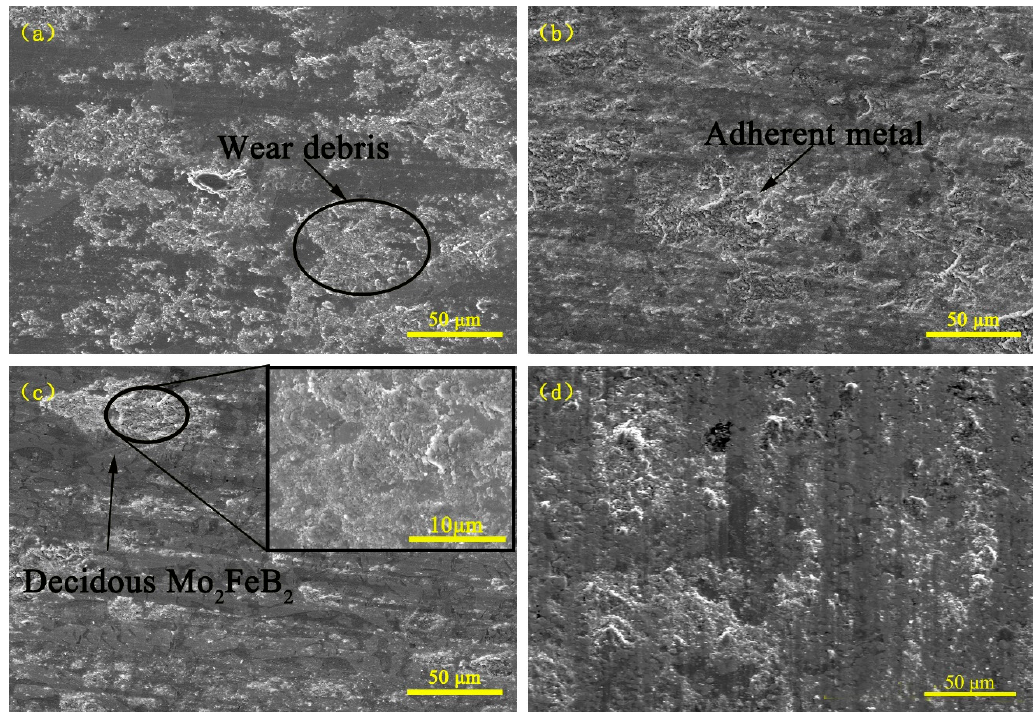
Figure 12. Wear morphology of claddings with different RE contents: ( a ) RE = 0%; ( b ) RE = 2%; ( c ) RE = 8%; ( d ) sintered sample.